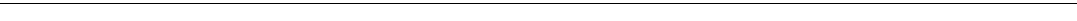
Figure 6 | In vivo tumour-targeting efficiency of CaP-rHDL and its macropinocytosis dependence. ( a ) In vivo real-time NIR fluorescent imaging of the mice bearing intracranial C6 glioblastoma at 4, 8, 12 and 24h after i.v. injected with DiR-labelled CaP-LNC (DiR-CaP-LNC) and CaP-rHDL (DiR-CaP-rHDL). ( b ) Distribution of DiR-CaP-LNC and DiR-CaP-rHDL at 24h post-injection in the organs of the mice bearing intracranial C6 glioblastoma. ( c ) Qualitative and ( d ) semi-quantitative analysis of the tumour accumulation of DiR-CaP-LNC and DiR-CaP-rHDL at 3h post-injection in the mice bearing intracranial C6 glioblastoma after the pretreatment with EIPA (30 m gg (cid:2) 1 body weight, i.p.) or vehicle only. ( e ) Brain distribution of DiI-CaP-LNC and DiI-CaP-rHDL at 3h post-injection in the mice bearing intracranial C6 glioblastoma after the pretreatment with EIPA (30 m gg (cid:2) 1 body weight, i.p.) or vehicle only. Red lines showed the boundary between glioblastoma and normal brain tissue. Arrows indicate the glioblastoma zones. Scale bar, 100 m m. ( f ) Qualitative and ( g ) semi- quantitative analysis of the tumour accumulation of Cy5-CaP-LNC-PEG and Cy5-CaP-rHDL at 3h post-injection in the mice bearing GICs-derived glioblastoma after the pretreatment with EIPA (30 m gg (cid:2) 1 body weight, i.p.) or vehicle only. ( h ) Brain distribution of Cy5-CaP-LNC-PEG and Cy5-CaP-rHDL at 3h post- injection in the mice bearing GICs-derived glioblastoma after the pretreatment with EIPA (30 m gg (cid:2) 1 body weight, i.p.) or vehicle only. Scale bar, 100 m m. For d and g , data represent mean ± s.d. ( n ¼ 3). The significance of the differences ( *P o 0.05, *** P o 0.001) was evaluated by two-tailed Student’s t